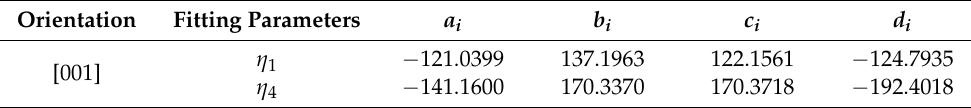
Table 6. Creep model parameter fitting